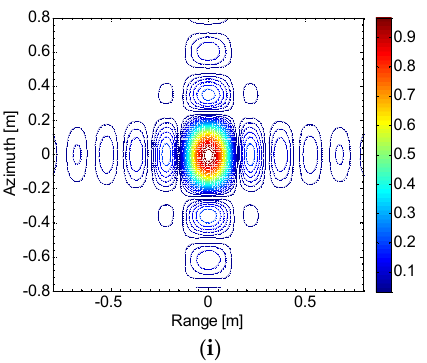
Figure 13. Imaging results of P 2 , the point at the range edge. Images ( a – i ) are in accordance with Figure 12.